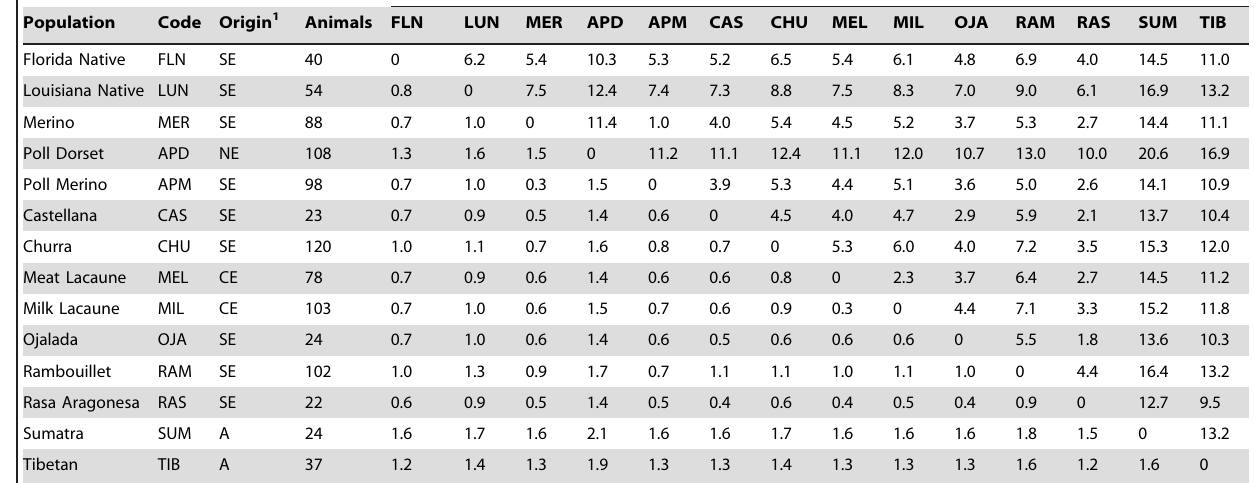
Table 1. Population divergence measured as F ST (%).